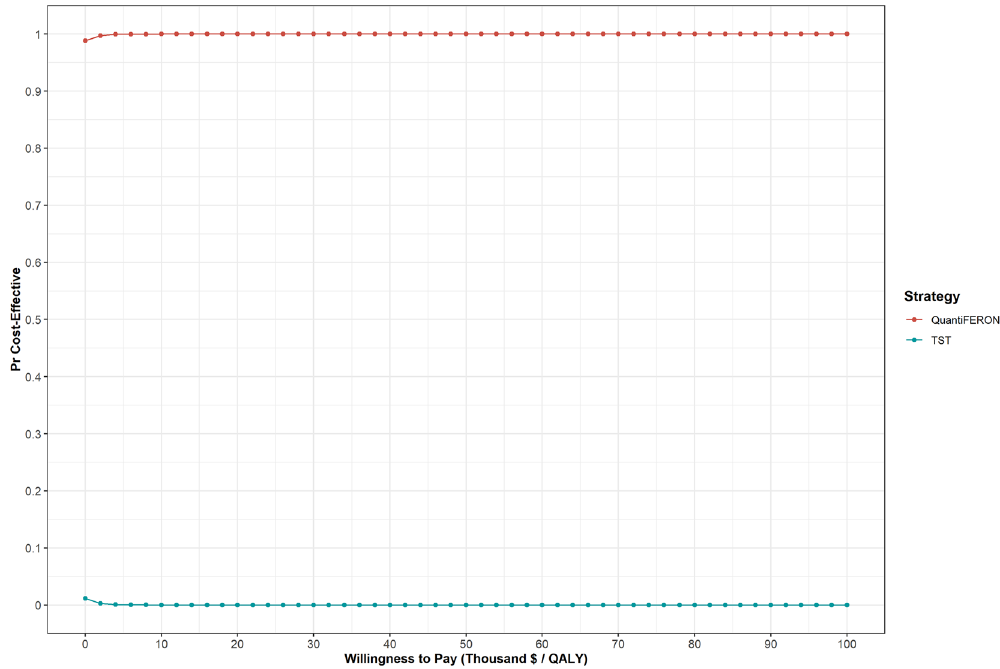
Figure 3. Cost-effectiveness acceptability curves. The results of the probabilistic sensitivity analysis represented as a cost-effectiveness acceptability curves for QuantiFERON-TB Gold Plus (QuantiFERON) versus the tuberculin skin test